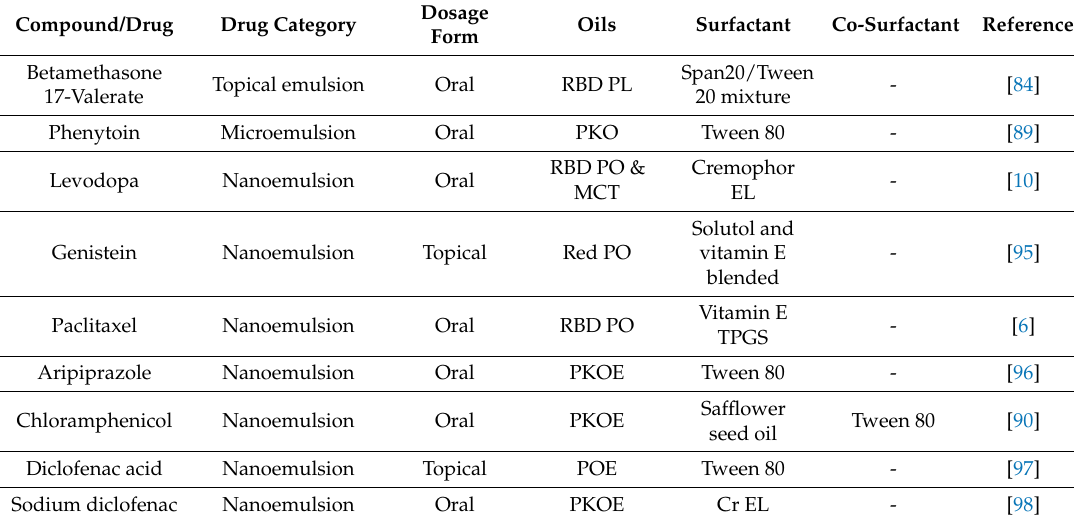
Table 2. Summary of Type I LBF using palm oil. Refined–bleached–deodorised palm olein (RBD